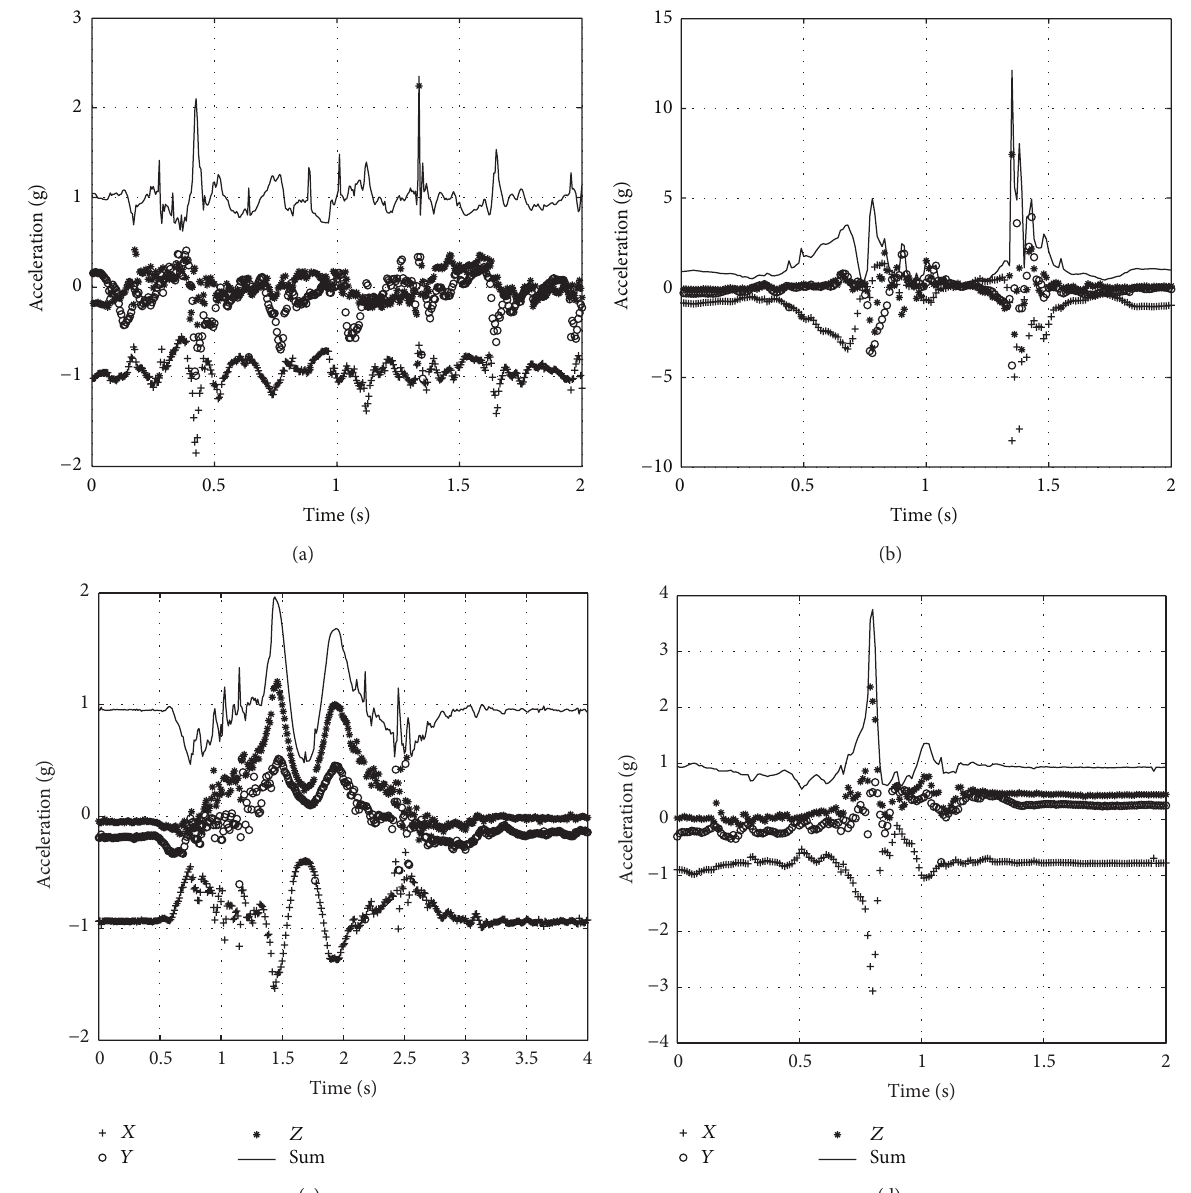
Figure 11: Acceleration waveform during ADL. (a) Walking. (b) Jumping. (c) Squatting. (d)